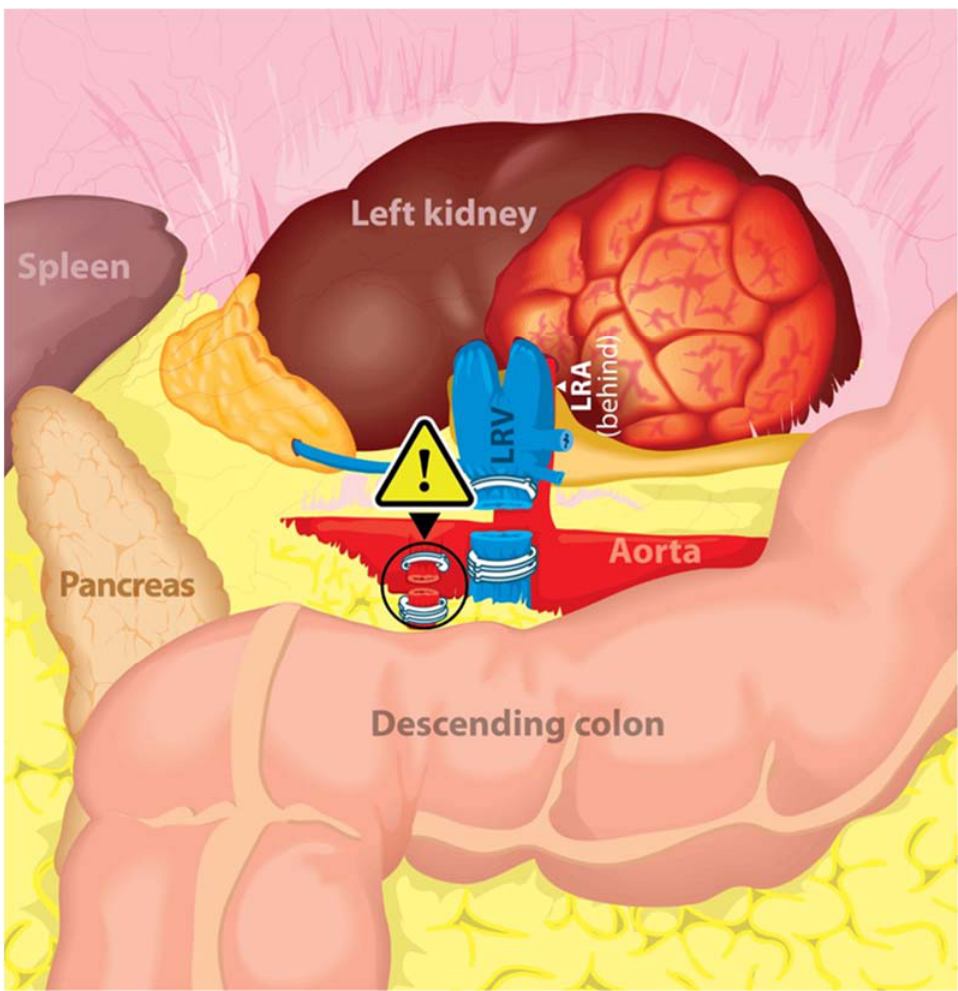
Figure 2. SMA complete transection after misidentification as the left renal artery. SMA: superior mesenteric artery; LRV: left renal vein; LRA: left renal artery.